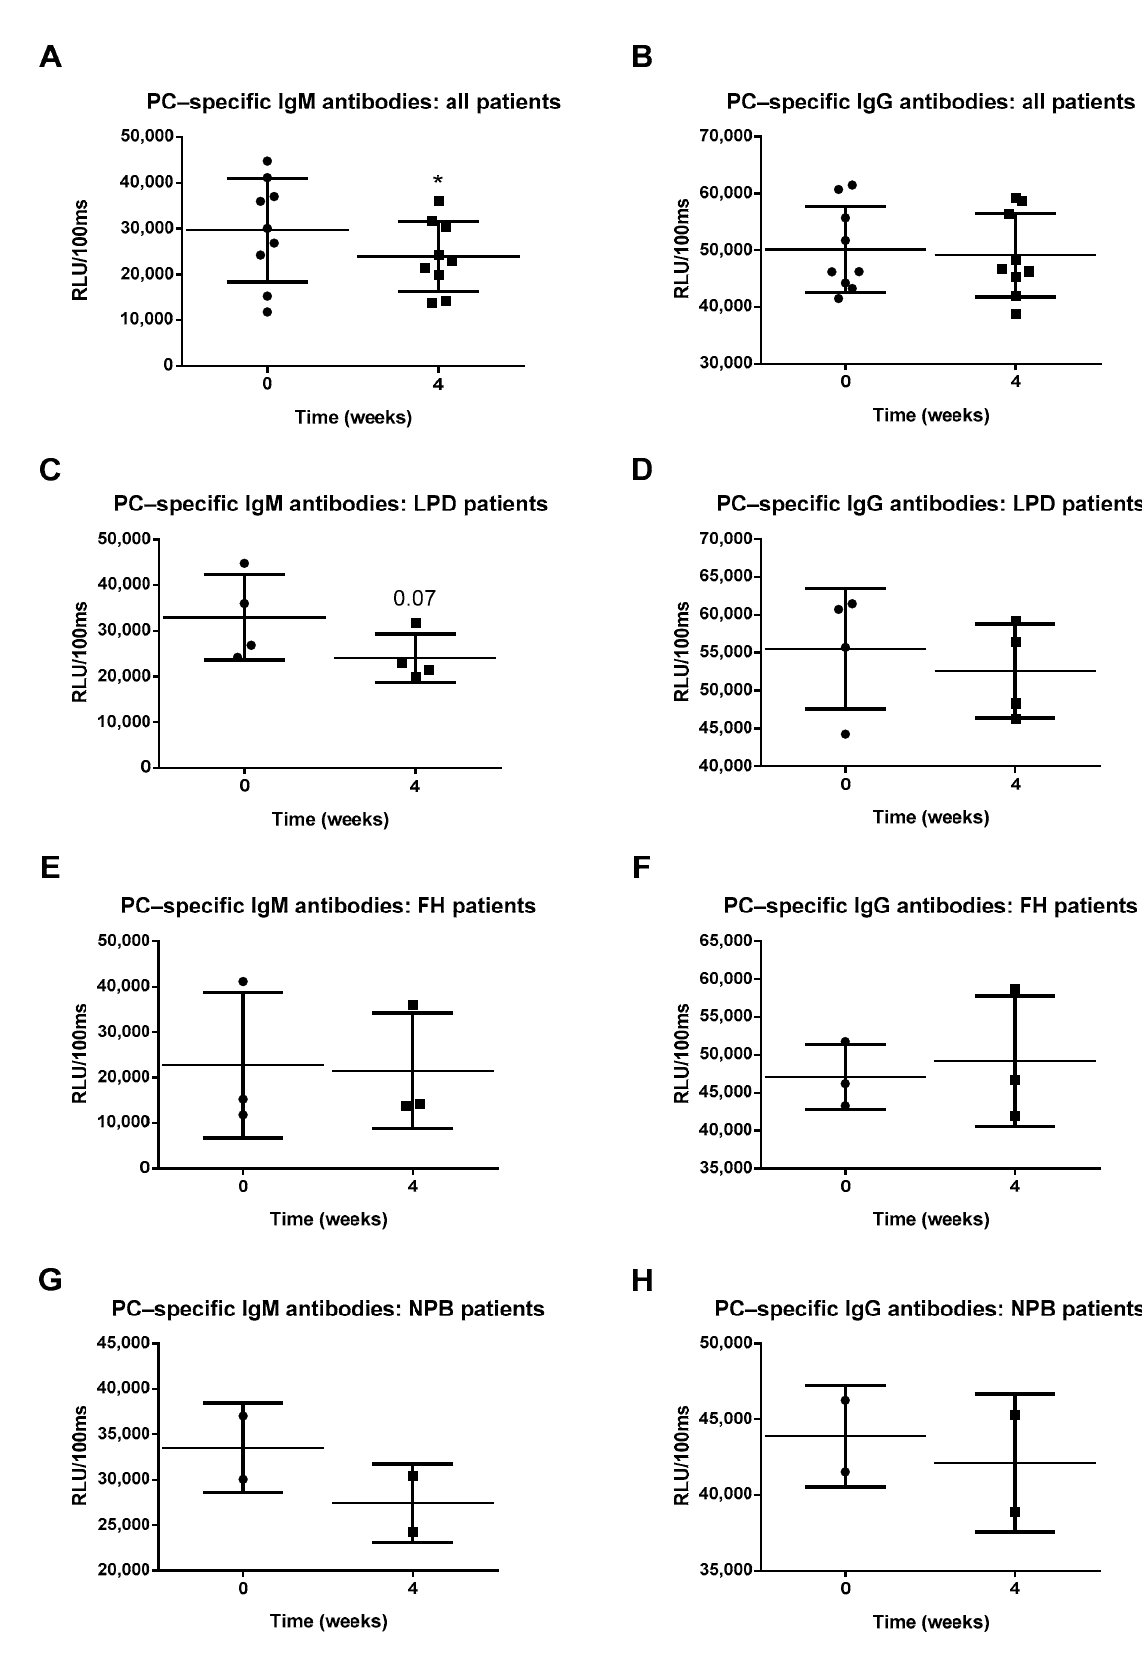
Figure 4. Phosphorylcholine (PC)-specific antibody titers ( A – H ). * Indicates p < 0.05. All error bars represent SD.